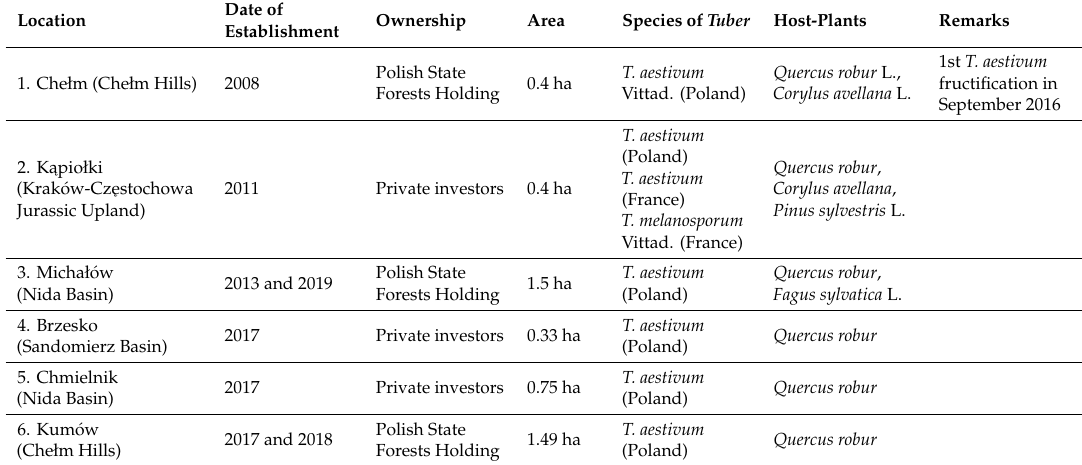
Table 1. Tru ffl e orchards under care of the Forest Research Institute.